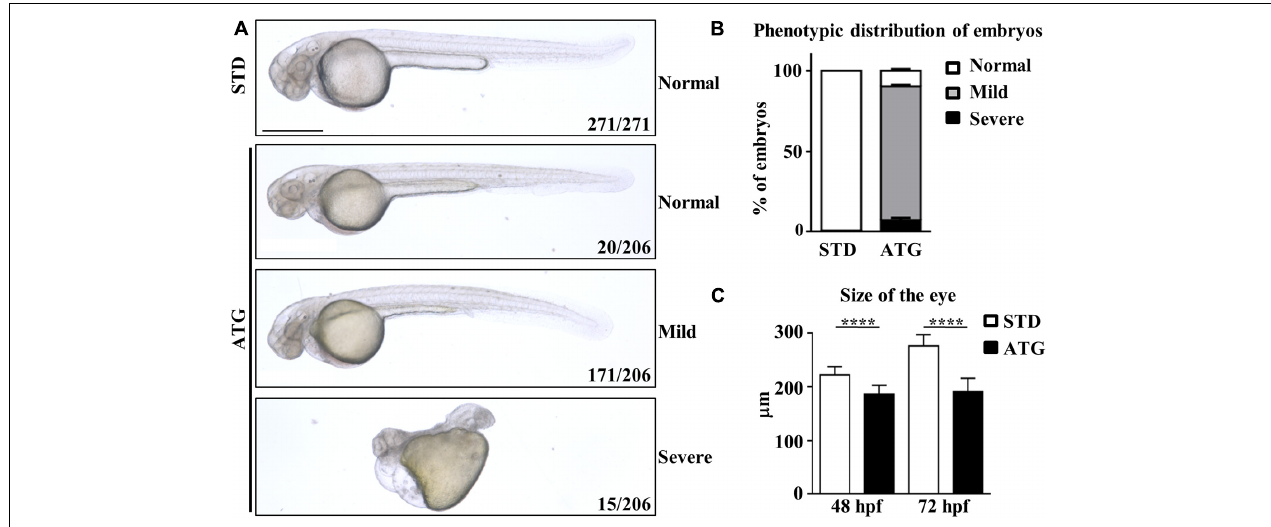
FIGURE 2 | Morphological analysis of embryos micro-injected with an ATG-blocking morpholino. Embryos were injected with the gene a -specific (ATG) or the control (STD) morpholino at 1/2 cell stage and analyzed at the microscope at 48 and 72 hpf. (A) Representative images showing the main features of controls and morphants at 48 hpf. Numbers in each panel represent total embryos used for the experiment and embryos with the phenotype shown in the image. (B) The graph shows the percentage distribution of embryos with normal or abnormal (mild and severe) morphology in each microinjection category. (C) The graph show the mean size of the eye diameter in controls and morphants ( N > 40) at 48 and 72 hpf. Size bar = 500 µ m. **** P < 0.0001 (unpaired, two-tailed T -Test). Experiments were repeated at least three times.